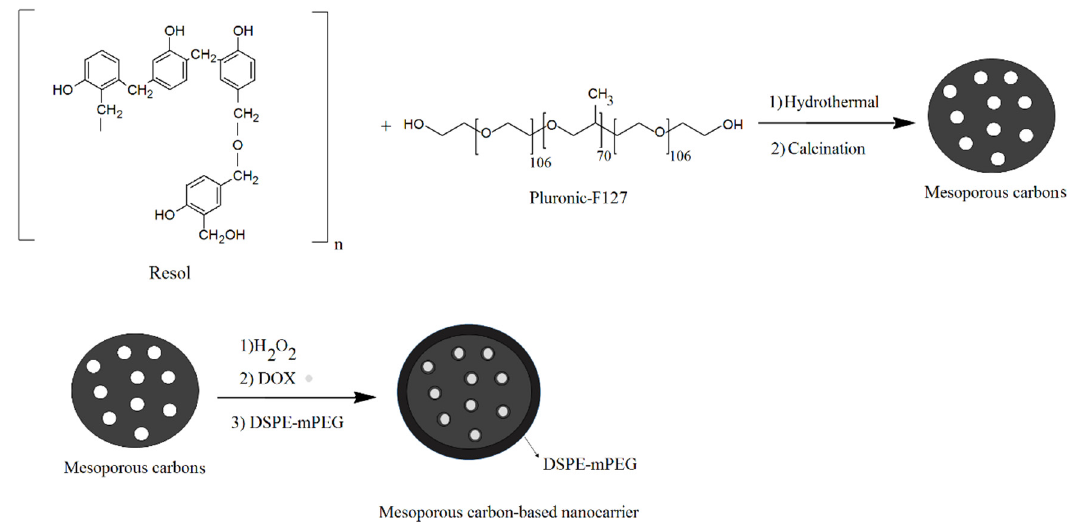
Figure 7. Synthesis of drug-loaded mesoporous carbons.